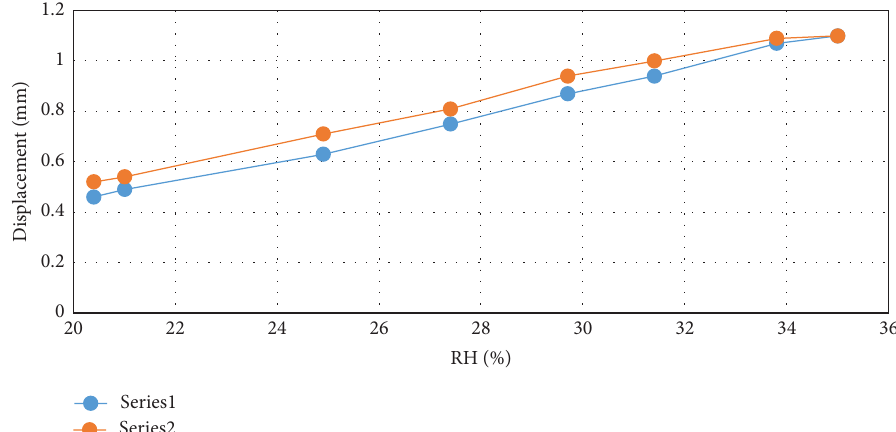
Figure 10: Plots show the behavior of the interference line displacement as a function of RH%. Series 1 (blue color) shows when the RH was rising and series 2 (red color) when RH